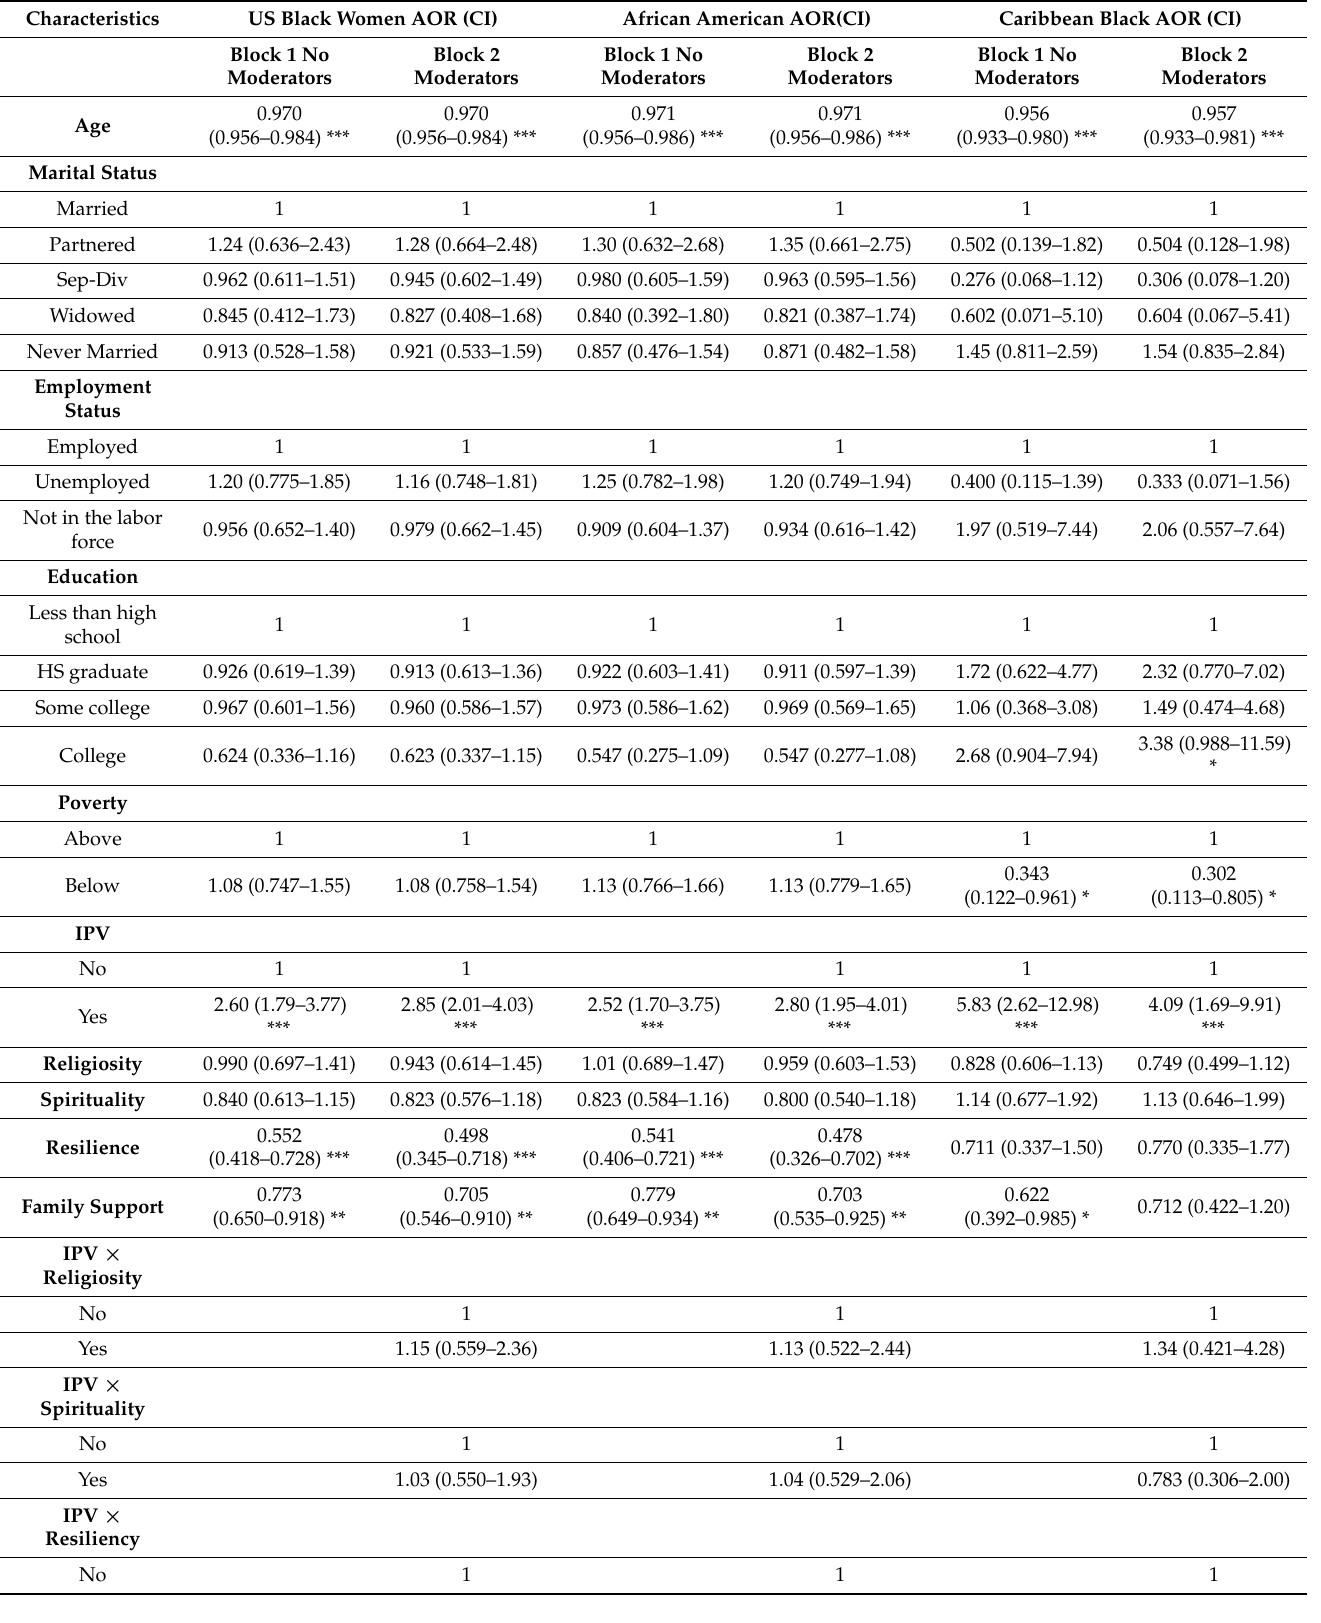
Table 4. Multivariate Analysis Examining IPV and Moderators on Suicide